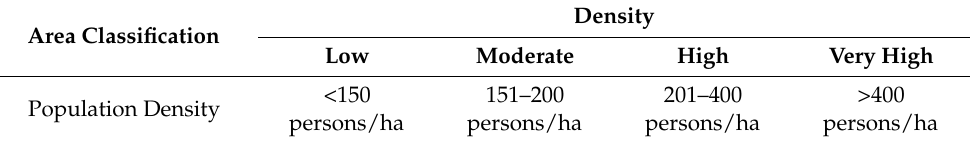
Table 2. The classification of areas based on population density based on BSN data